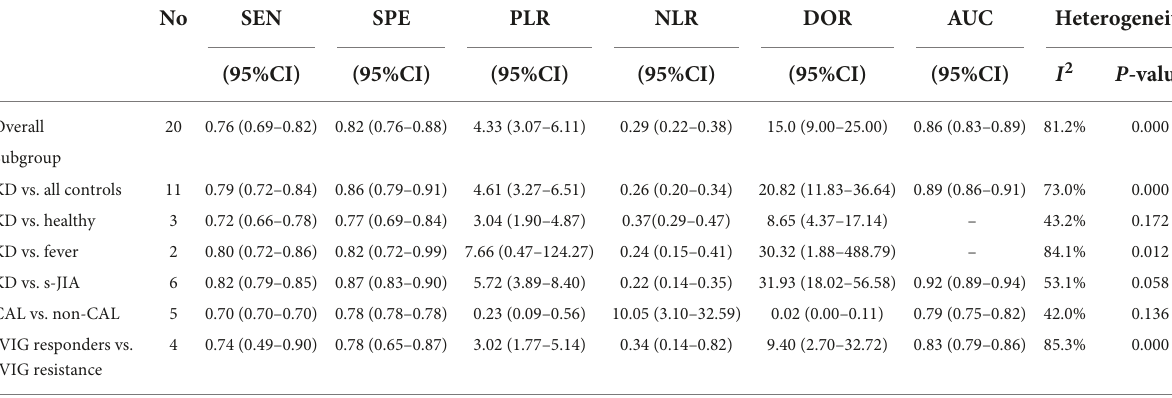
TABLE 4 Subgroup analysis of diagnostic accuracy of overall SF for